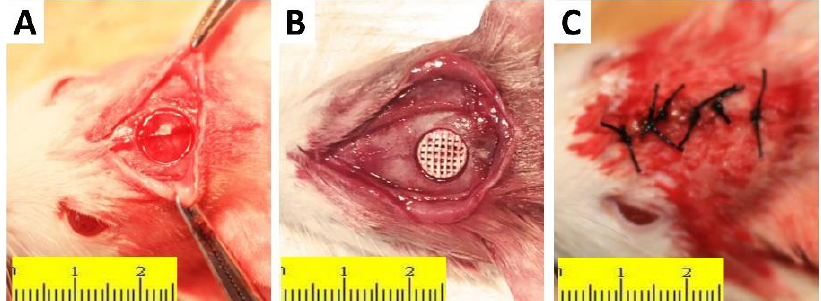
Figure 10. Osteogenesis of the Scaffold. Establishment process of rat large-sized skull defect model. ( A ) A round bone defect with a diameter of 8 mm was made in the skull of the rat. The brain and other structures were not damaged. ( B ) A stent with a diameter of 8 mm was inserted into the defect and the edges were almost identical. ( C ) Silk suture wound, good alignment, no obvious bleeding exudation was observed.